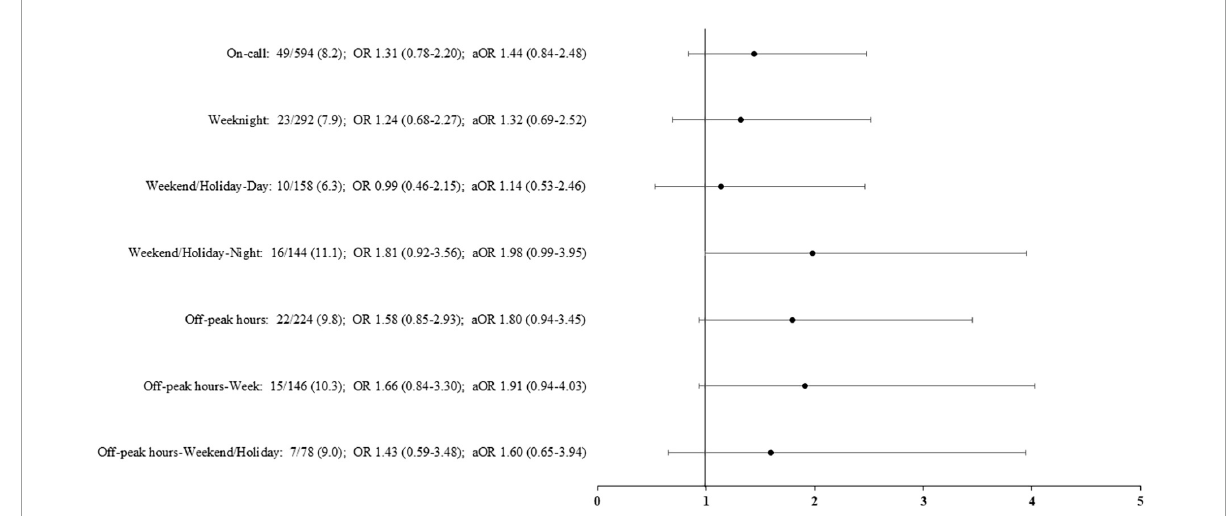
FIGURE3 Rates of early death (within 7 days) according to the period of birth. Adjusted odds ratio (aOR), weighted by the propensity score, and their 95% confidence interval shown of the figure, are expressed vs. weekday. On-call: defined as birth in weekdays between 6.30 p.m. and 8.30 a.m., in weekends and public holidays. Off-peak hours: defined as birth between 12:00 a.m. and 6:59 a.m.